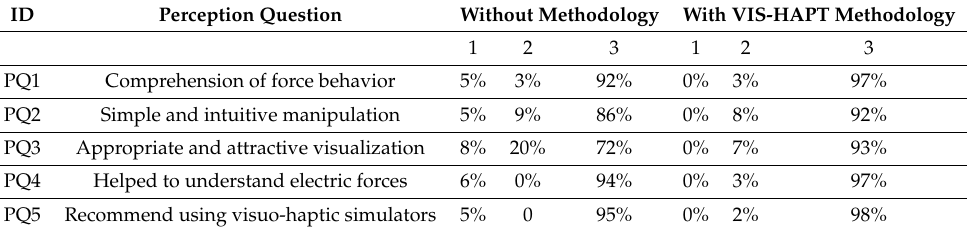
Table 4. Questions on the exit perception survey for electric force simulators, adapted from [28] without methodology and [6] with the proposed